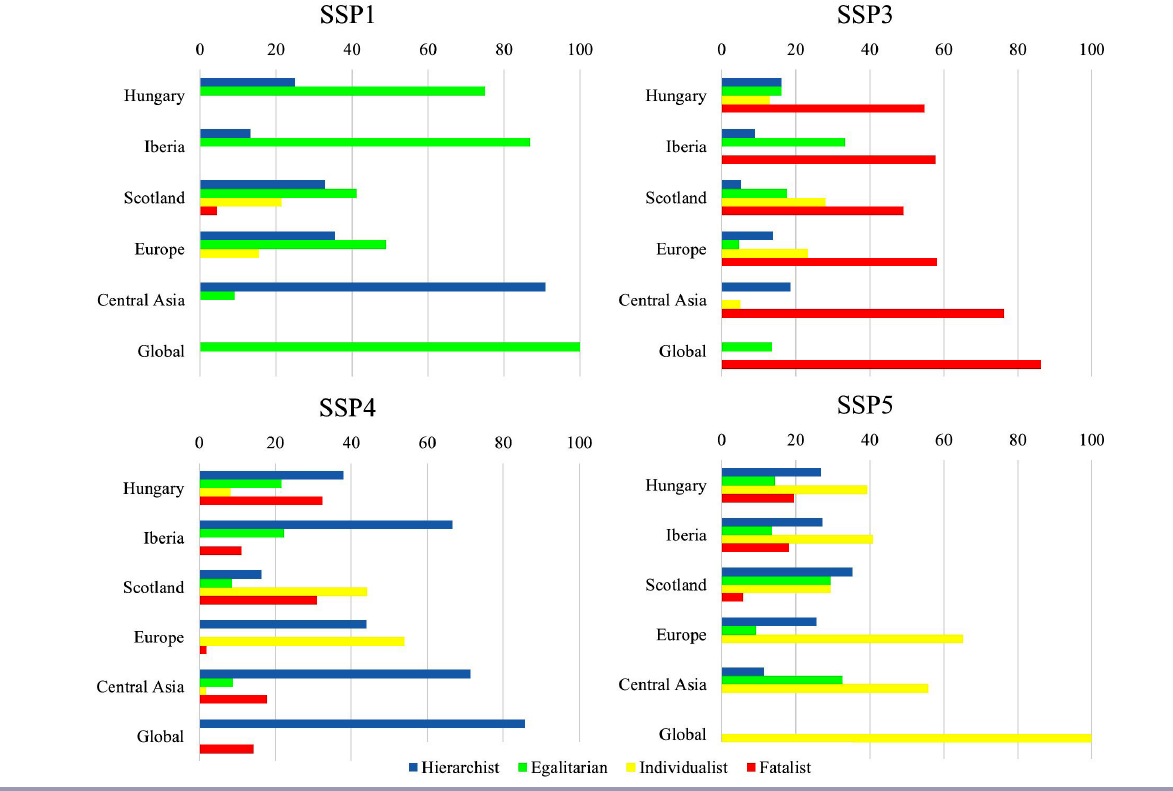
Fig. 2 . Frequency count (in %) of worldviews in the case studies: Hungary, Iberia, Scotland, Europe, and central Asia. Example from expert 1. The bottom case study is the analysis of the global sketch narratives from O’Neill et al. (2017). SSP, shared socioeconomic